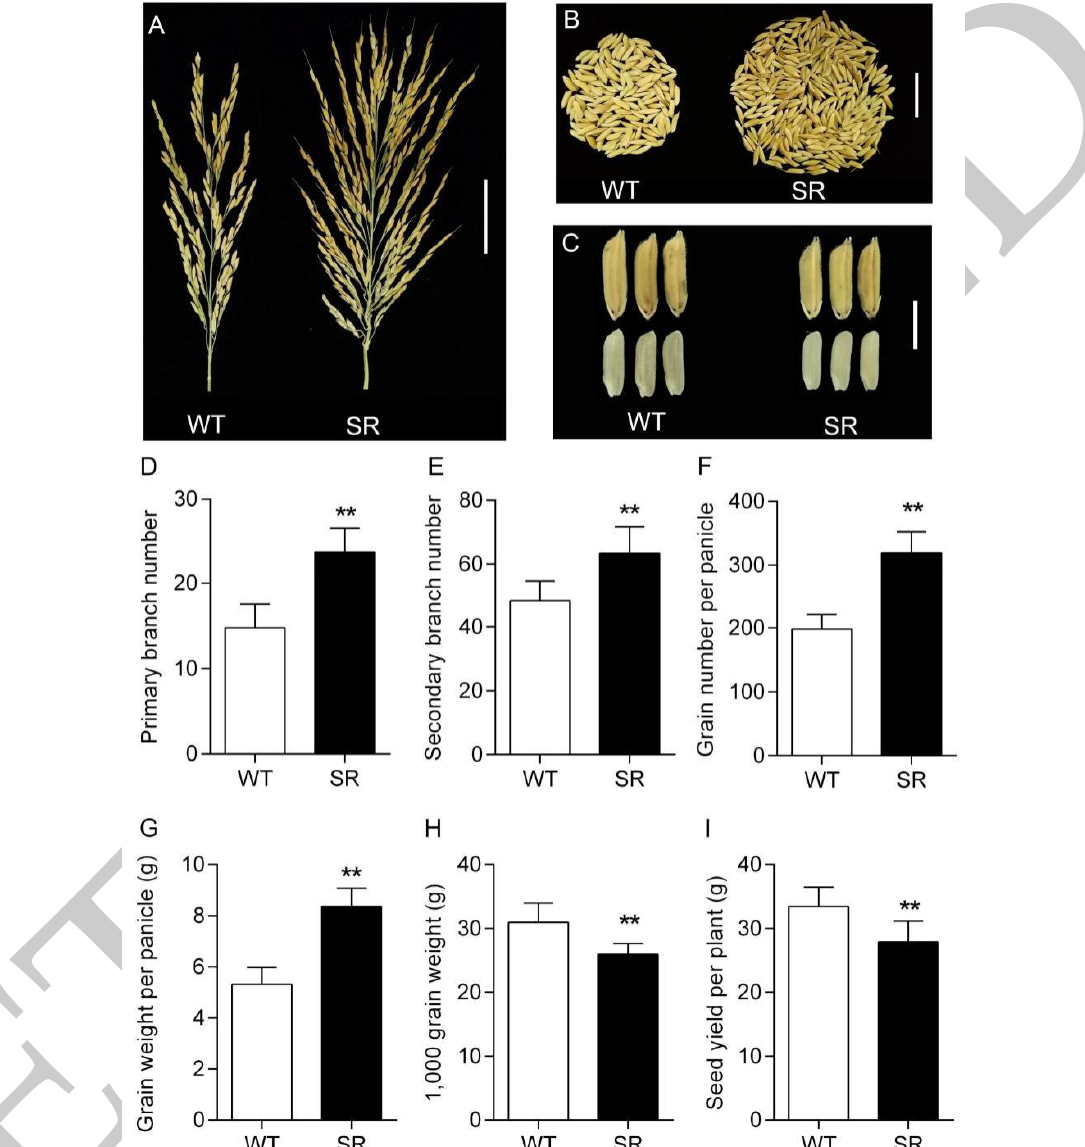
Figure 8. SR forms large and heavy panicle. ( A ) Representative photograph of panicle morphology of SR plant. Bar, 5 cm. ( B ) Seed yield per panicle of WT and SR. Bars, 2 cm. ( C ) Mature paddy (top) and brown (bottom) rice grains of WT and SR. Bars, 1 cm. ( D ) Number of WT and SR primary panicle branches. ( E ) Number of WT and SR secondary panicle branches. ( F ) Grain number per panicle of WT and SR. ( G ) Grain weight per panicle of WT and SR. ( H ) 1000 grain weight of WT and SR. ( I ) Seed yield per plant of WT and SR. Values ( D – I ) are given as means ± SD ( n ≥ 15). ** p < 0.01 compared with the WT by Student’s t -test.